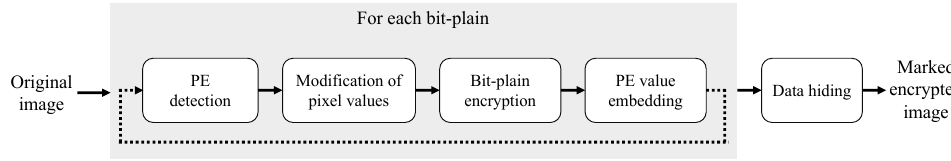
Figure 1. Block diagram of RDH-MSB method [29].